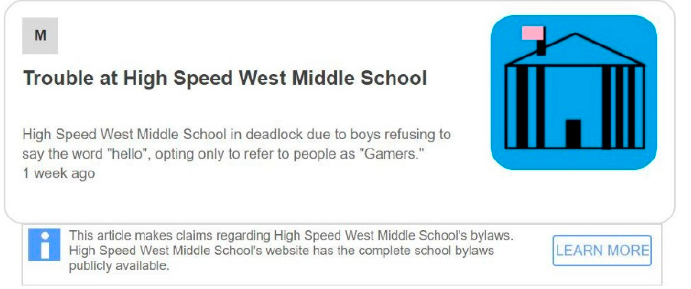
Figure 16. Label 10—Example of an unconditional supplemental informational label.